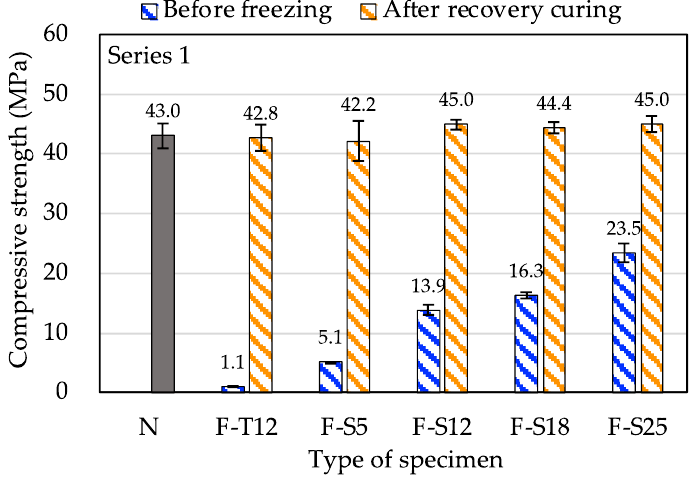
Figure 4. The compressive strength after recovery curing in Series 1.